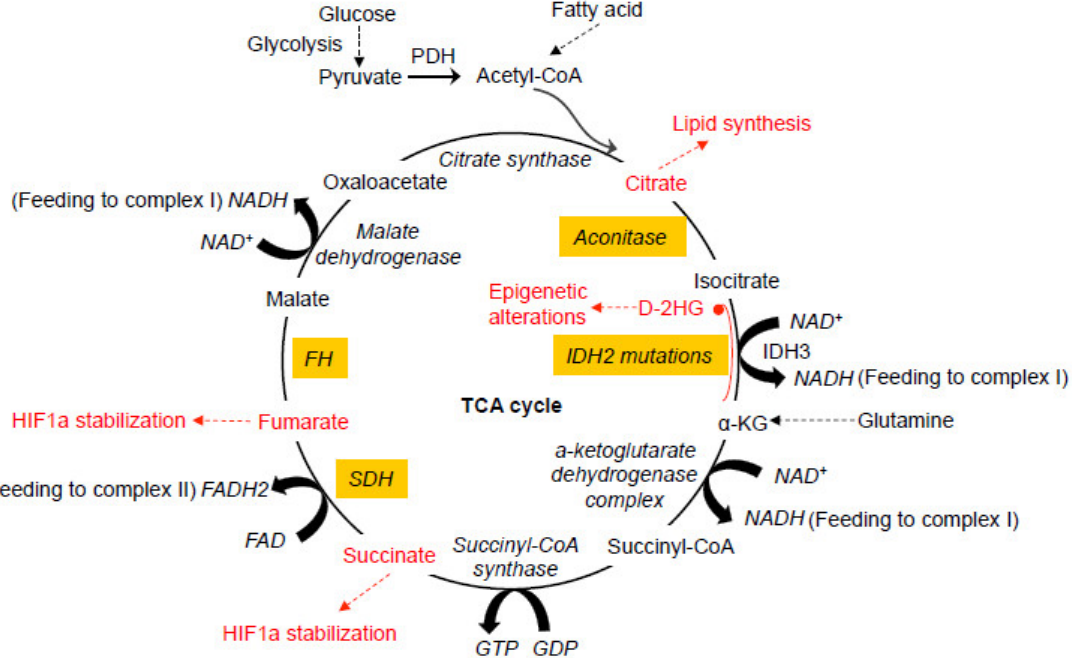
Figure 1. Dysfunctional tricarboxylic acid (TCA) cycle enzymes in cancers. The normal TCA cycle deemed for the breakdown of acetyl-CoA is subject to disruption by oxidative stress and dysfunction of the TCA cycle enzymes, contributing to various cancers. Mutations in IDH2 can lead to the production of D-2HG from α -KG. Abnormal accumulation of 2-HG causes epigenetic landscape alterations and inhibits SDH, resulting in the accumulation of succinyl-CoA and mitochondrial respiration impairment. Mutations in SDH cause abnormal accumulation of succinate and subsequent inhibition of PHDs, resulting in HIF1a stabilization. Like SDH, mutations in FH also cause HIF1a stabilization. Oxidative stress induced by the dysfunction of mitochondrial electron transport chain causes abnormal modification of the iron-sulfur center in aconitase, leading to the exportation of citrate from mitochondria for cholesterol and fatty acid synthesis. All of these abnormal alterations in the TCA cycles have been more or less implicated in neoplastic transformation of di ff erent types at di ff erent degrees. PDH, pyruvate dehydrogenase. PHD, HIF prolyl hydroxylase. D-2HG, D enantiomer of 2-hydroxyglutarate. α -KG, alpha-ketoglutarate. IDH, isocitrate dehydrogenase. SDH, succinate dehydrogenase. FH, fumarate hydratase.